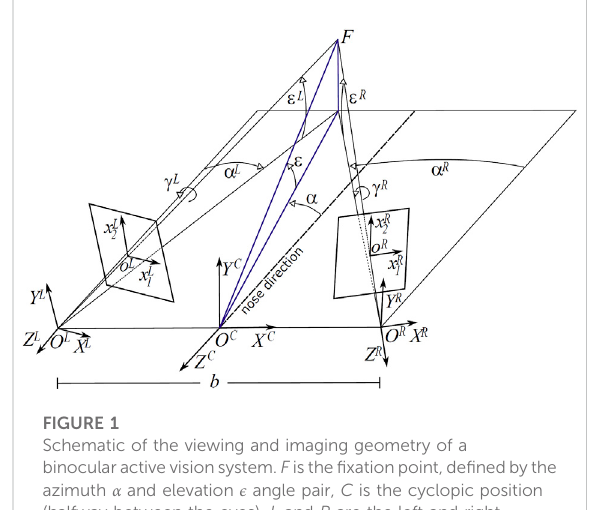
FIGURE 1 Schematic of the viewing and imaging geometry of a binocularactivevisionsystem. F isthe fi xationpoint,de fi nedbythe azimuth α and elevation ϵ angle pair, C is the cyclopic position (halfway between the eyes), L and R are the left and right camera positions, separated by abaseline b = 60 mm. The ϵ L / R , α L / R and γ L / R values stand for the elevation (pitch), azimuth (yaw) and torsion (roll) angles of the left L and right R eye.